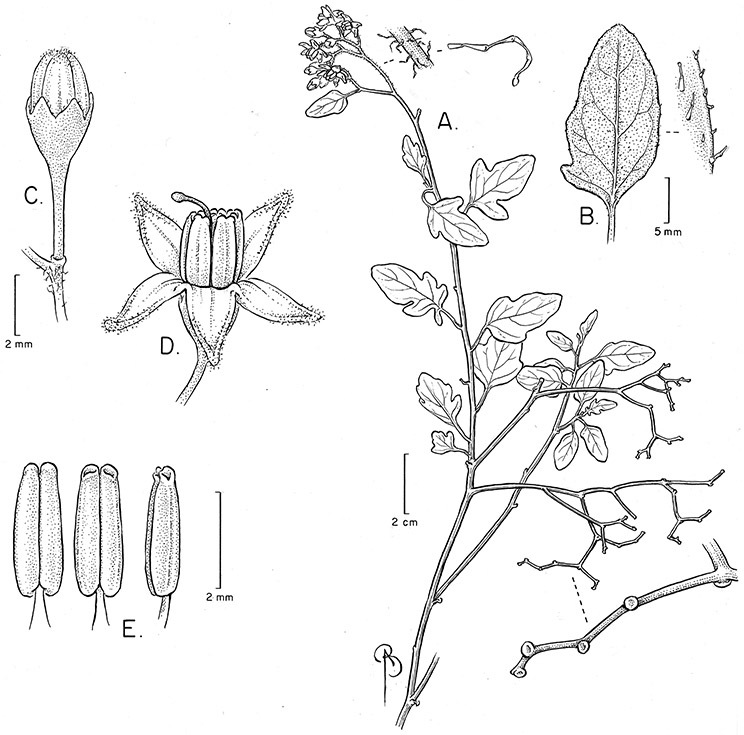
Solanum alphonsei Dunal. (A–H drawn from Anon. s.n., Mar 1858, BM). Illustration by Bobbi Angell.